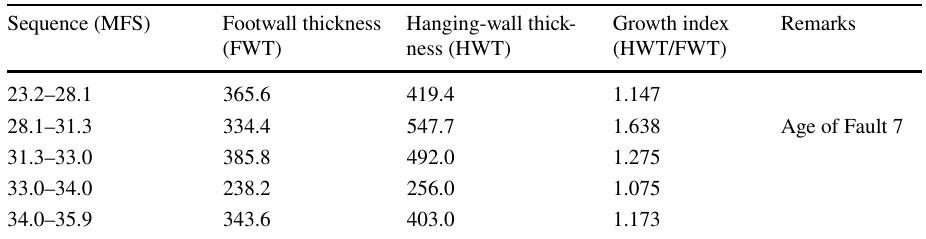
Table 3 Growth fault index computation for fault 7 showing the age at which fault 7 started forming